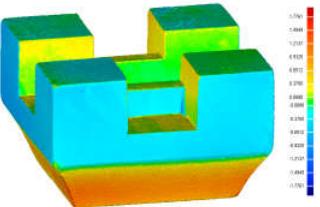
Figure 11. Results of three-dimensional deviation analysis for